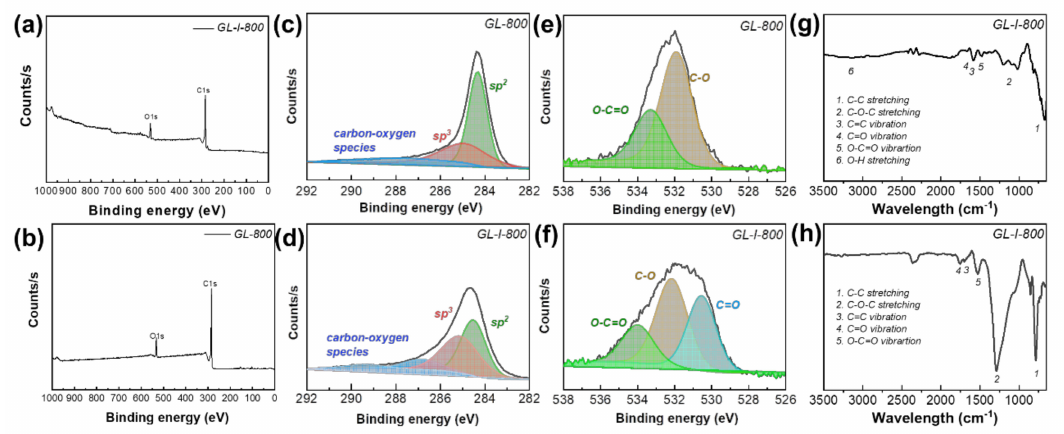
Figure 2. X-ray photoelectron spectroscopy (XPS) survey spectra of ( a ) GL-800 and ( b ) GL-I-800. Deconvolution of the high-resolution XPS spectra of GL-800 and GL-I-800: ( c , d ) C 1s and ( e , f ) O 1s. FT-IR spectra of ( g ) GL-800 and ( h ) GL-I-800.